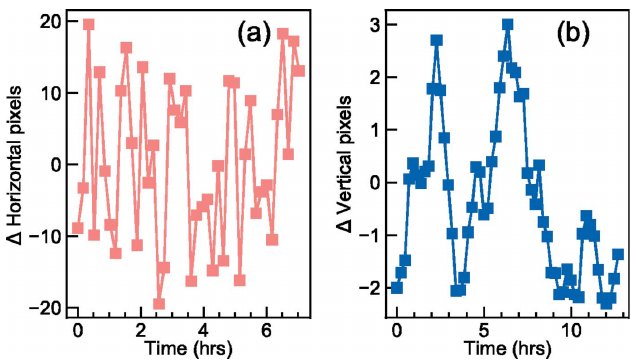
Figure 19 ( a ) Relative horizontal shifts in pixel values corresponding to the maxima of the RIXS signals on the CCD over time. ( b ) Relative vertical shifts in pixel values corresponding to the elastic peaks of the RIXS signals on the CCD over